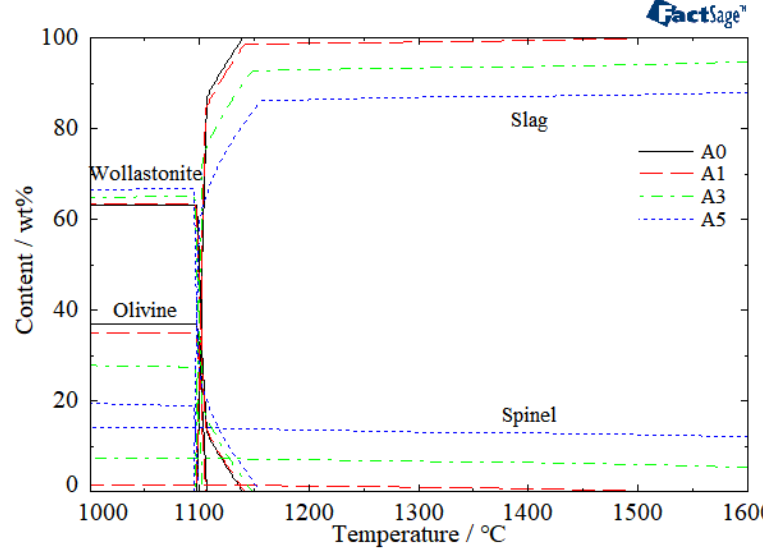
Figure 7. The solidification process of the CaO-SiO 2 -Fe t O-Cr 2 O 3 system.